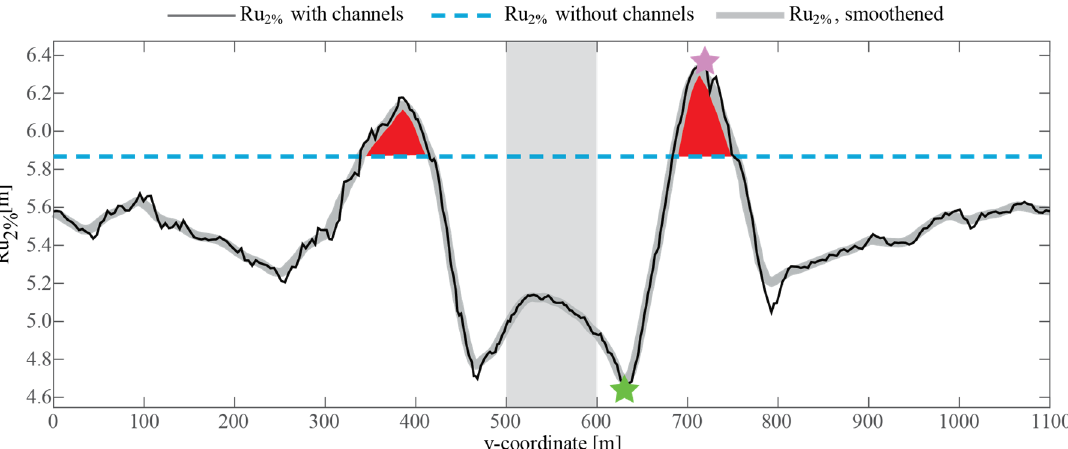
Figure 4. Alongshore patterns in runup, Ru 2% , for the reference case of a reef flat ( W r = 300 m) without a channel (dashed line) and with a channel (solid line) under identical large ( Ho = 7 m) and long-period ( T p = 15 s) offshore waves. High runup zones where Ru 2% exceeds the reference Ru 2% are indicated by the red regions. The peak in Ru 2% is indicated by a purple star; the lowest Ru 2% is indicated by the green star. The gray region denotes the location of the channel ( W c = 100 m).